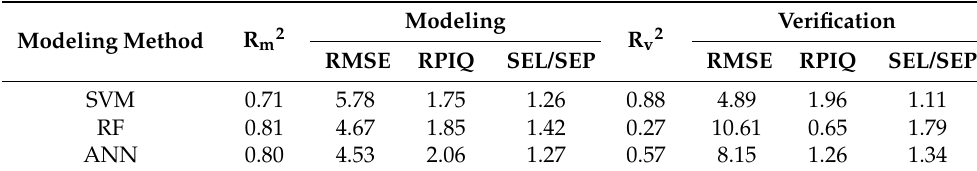
Table 3. Accuracy statistics of the Artificial Neural Network (ANN), Random Forest (RF),